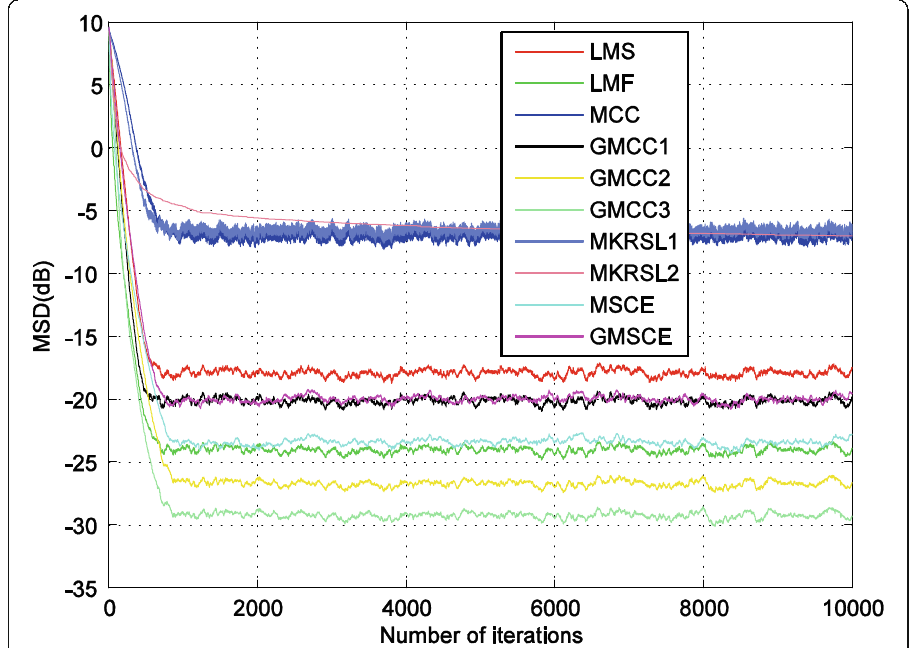
Fig. 3 Comparisons of the algorithms under sub-Gaussian noise shown in Fig.